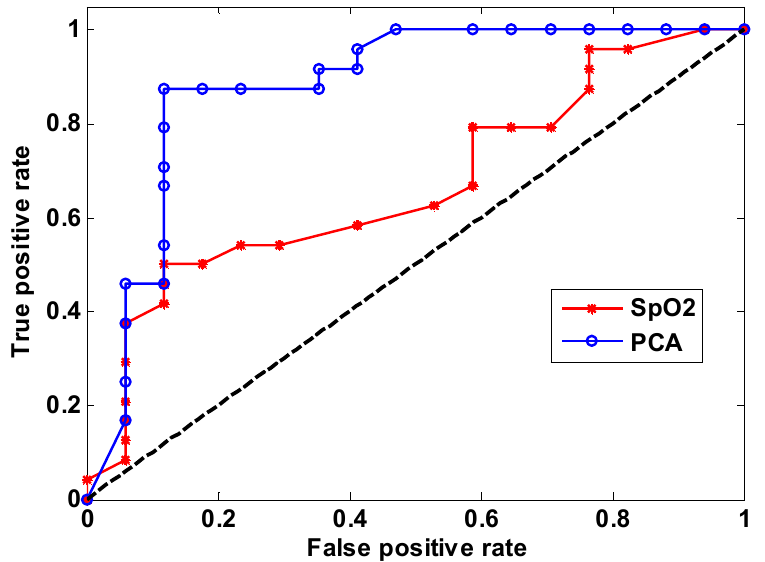
Figure 5. Receiver operating characteristic (ROC) analysis: red line indicates classification based on SpO 2 values adjacent to the wound site and blue line represents classification based on the absolute value of the PC2 score. Black dashed line is the worst case.